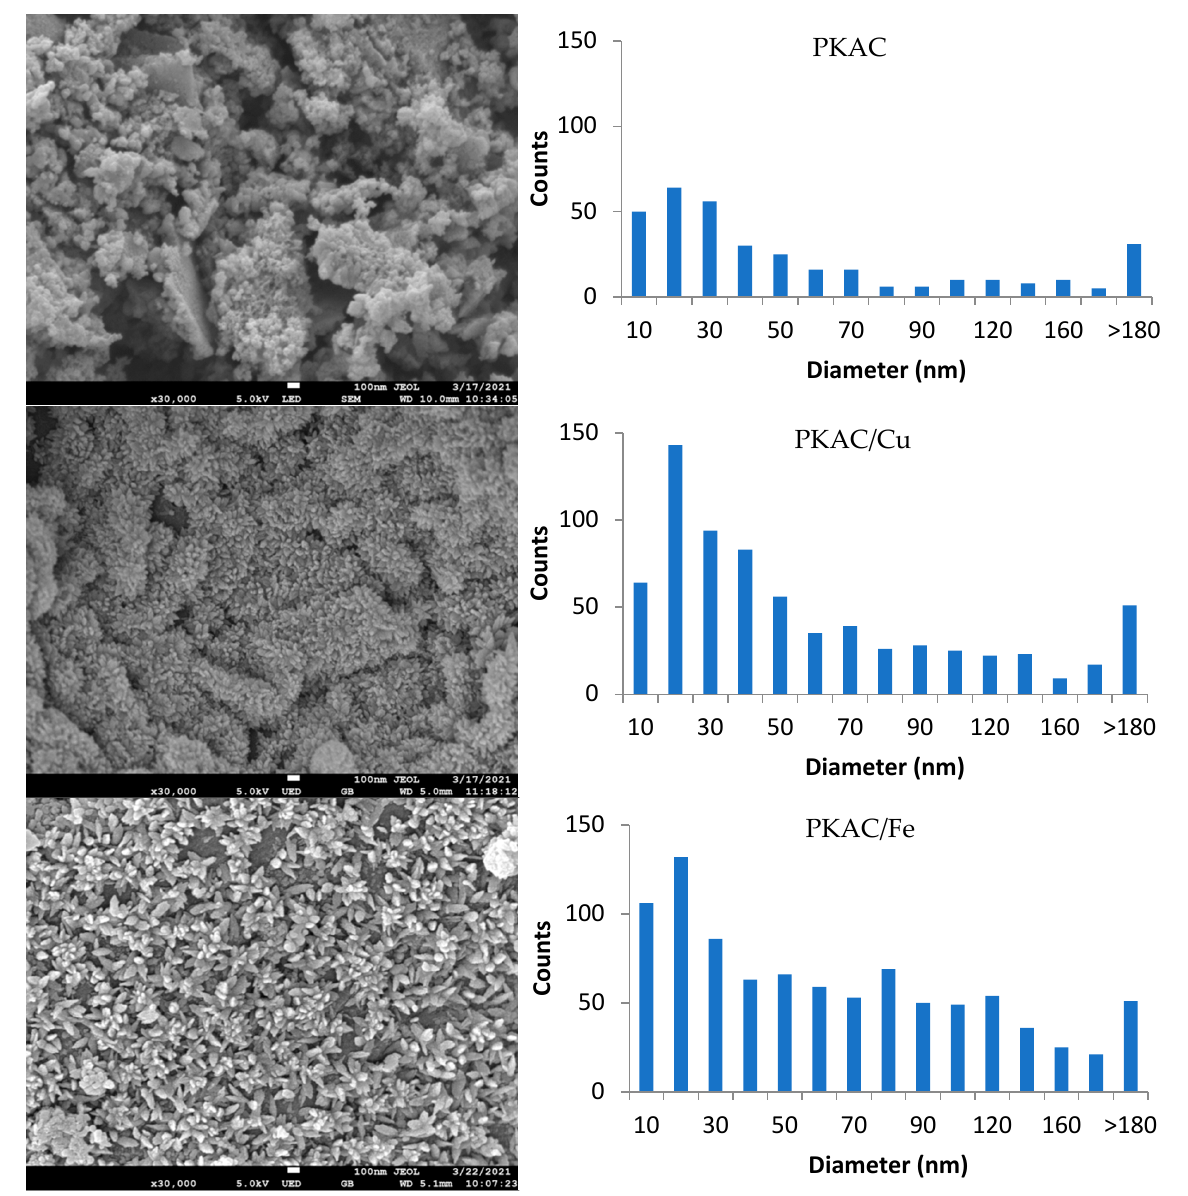
Figure 1. FESEM image and particle size distribution for PKAC and the monometallic catalysts at 30k magnification.